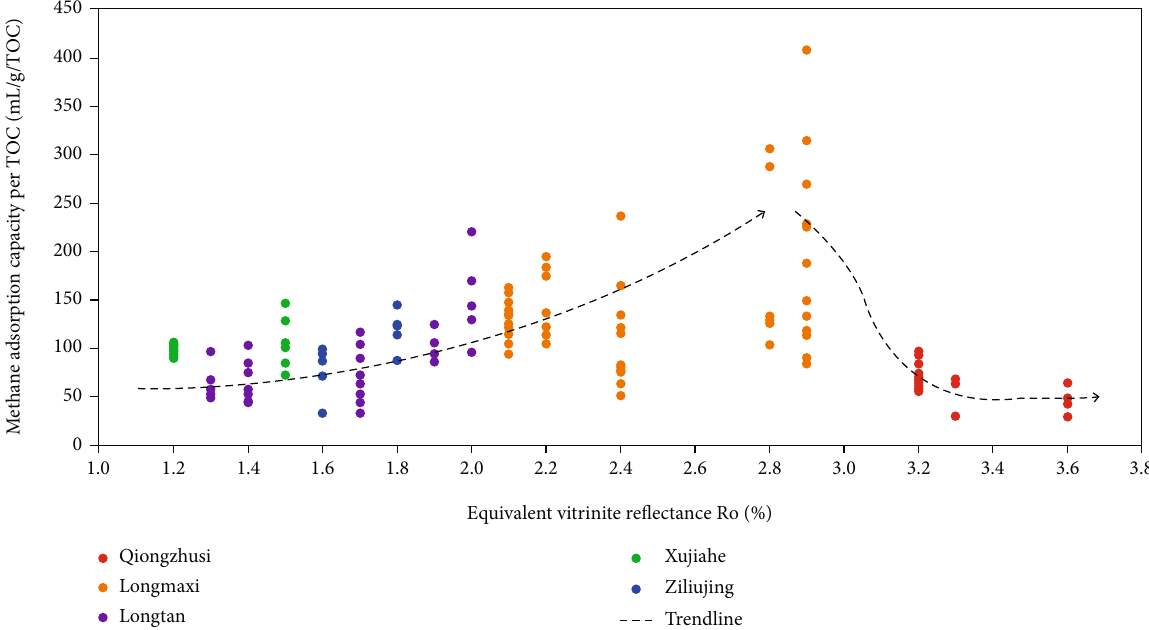
Figure 8: Relationship between methane adsorption capacity per TOC and maturity of di ff erent types of shale. With the increase of maturity, the adsorption capacity fi rst increased and then decreased.